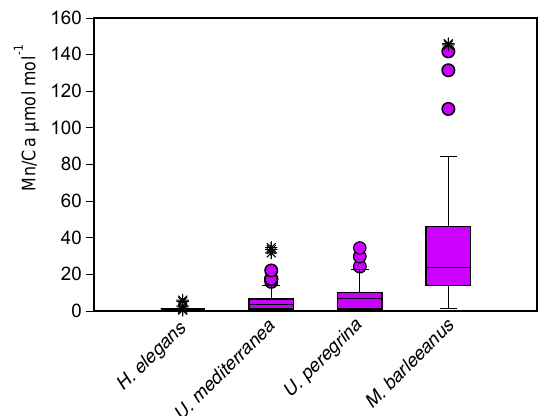
Figure 5. Box plots describing the distribution of Mn / Ca values measured in living (stained) individuals of Hoeglundina elegans , Uvigerina mediterranea , Uvigerina peregrina , and Melonis bar- leeanus . The box represents all values between the 25th and 75th percentile. The dissection line through the box denotes the median. The whiskers are drawn from the top of the box up to the largest data point less than 1.5 times the box height from the box and similarly below the box. Values outside the whiskers are shown as circles, and values further than 3 times the box height are denoted as